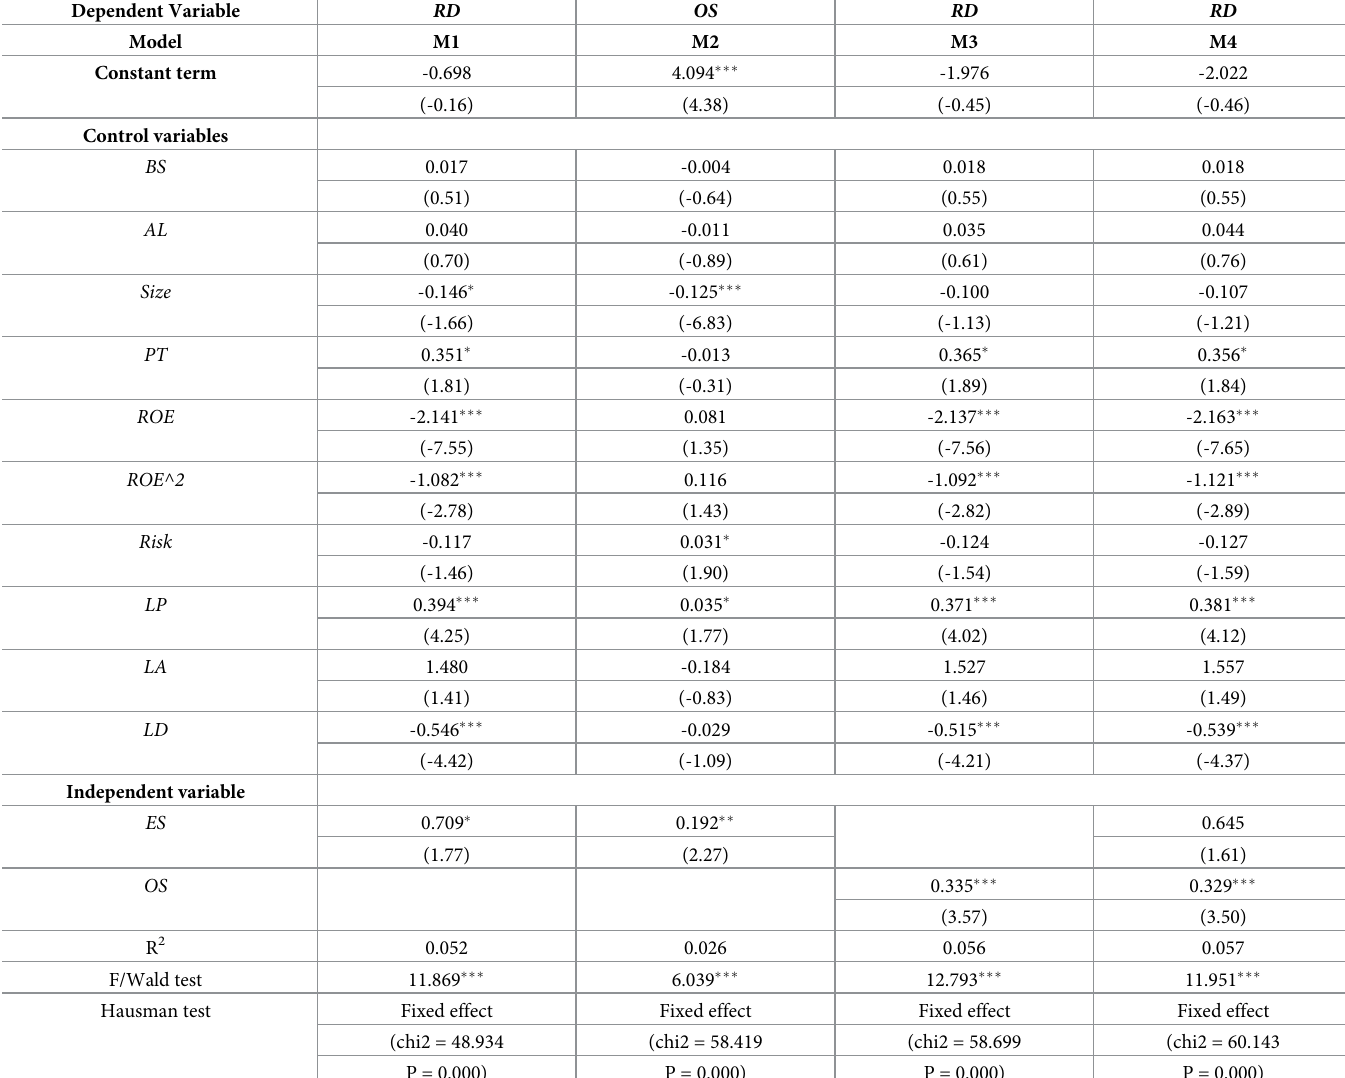
Table 4. Results of regression analysis—mediating